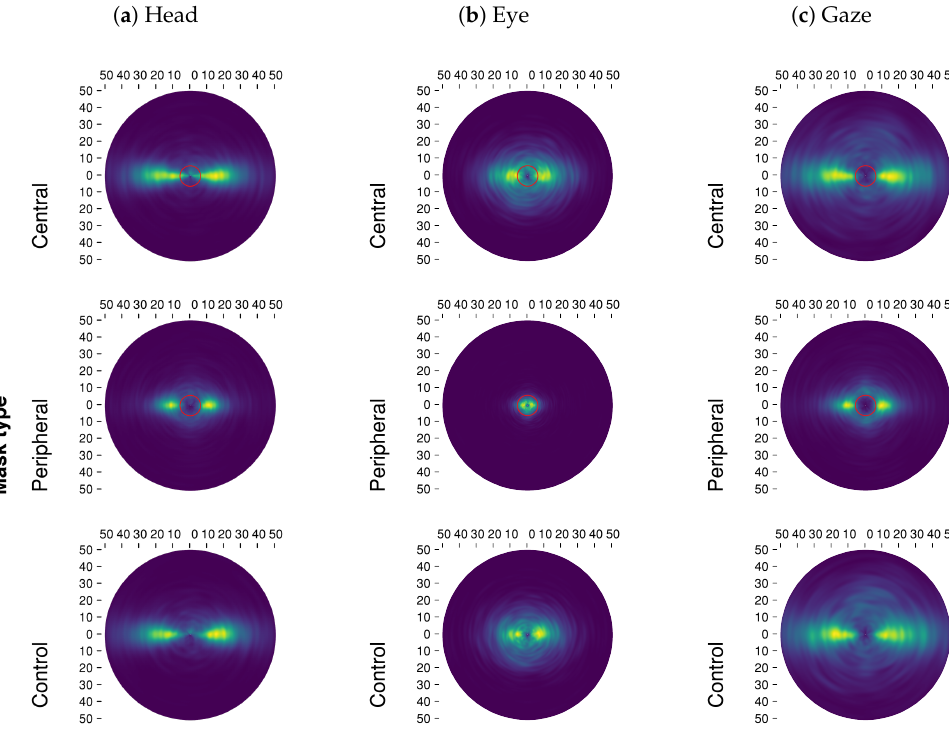
Figure A2. The joint distribution of saccade amplitudes and saccade absolute directions are presented in this figure for eye, head and gaze movements as a function of mask conditions. Red circles at